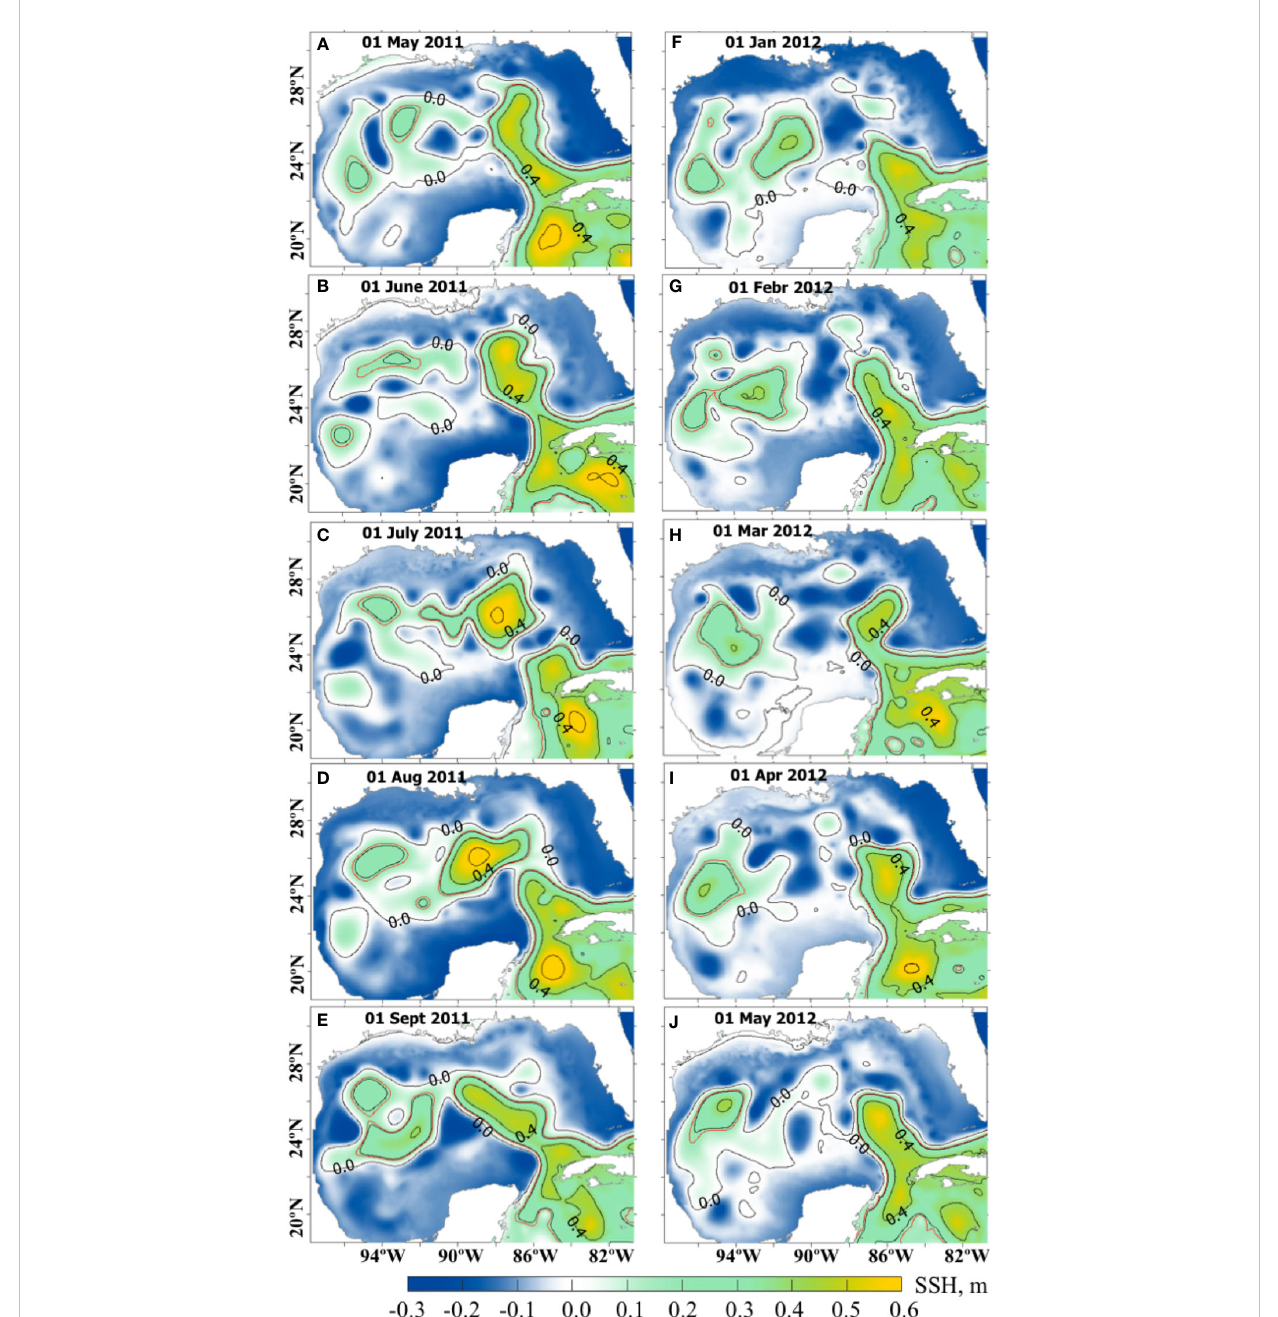
FIGURE 10 Daily SSH fi elds (m) from the NEMO NR. The left column (A – E) are SSH fi elds from May (A) – September (E) 2011 corresponding to the active state of the LC with several detachments and reattachments of the LCE. The right column (F – J) are SSH fi elds from the time interval January (F) – May (J) 2012 during which the LC is in a more stable position. Contours are every 0.2 m starting from 0. The red line is the 0.17 m contour used as a de fi nition of the LC and LCE